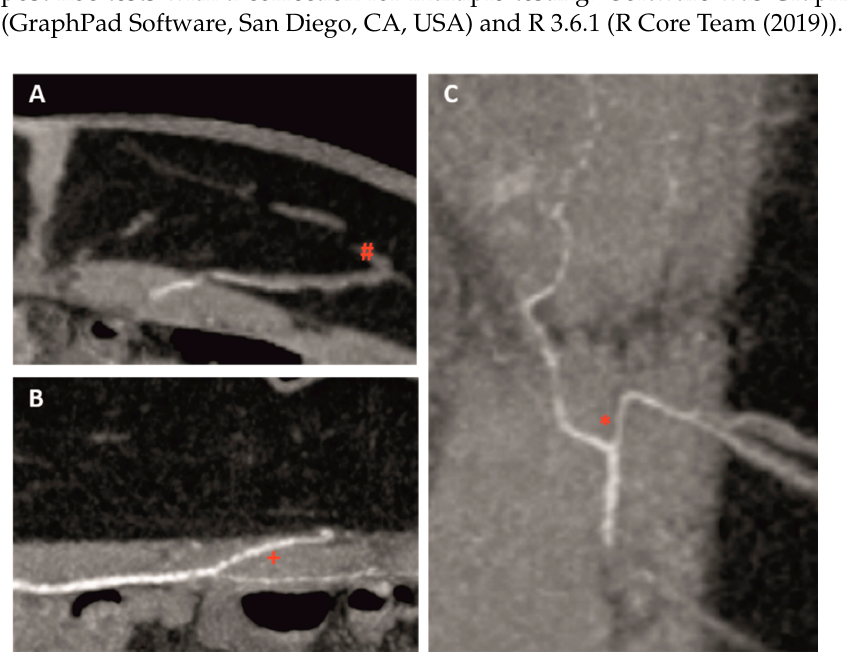
Figure 1. Perforator and DIEA mapping using computed tomographic angiography (CTA) in transversal ( A ), sagittal, ( B ) and coronar ( C ) view (#: connection to SIEV, +: intramuscular course, *: branching of DIEA). Table 1. Assessed parameters of CTAs.